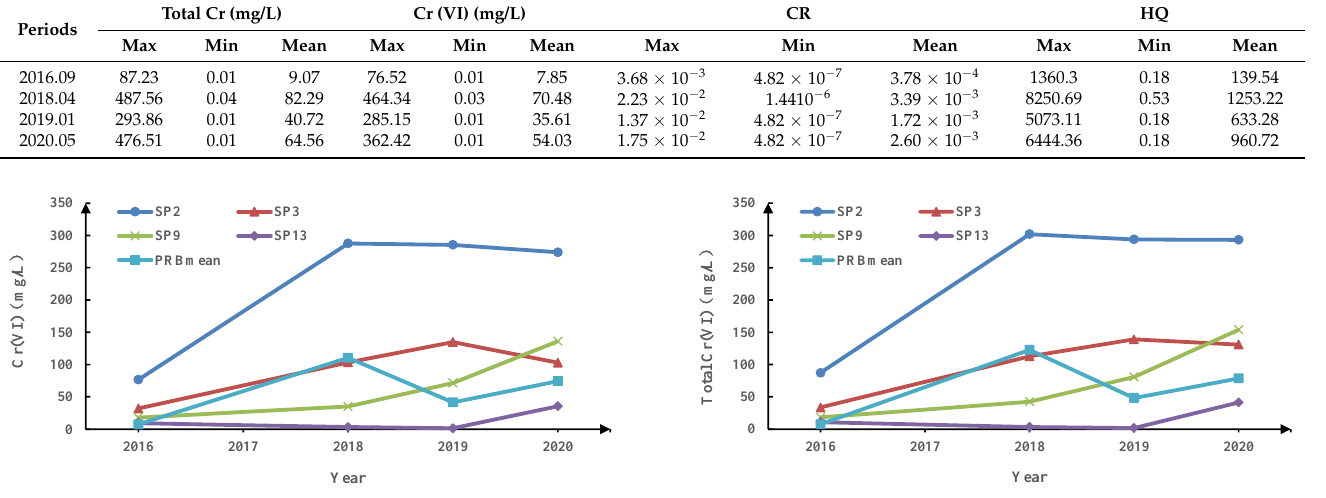
Table 2. Total Cr and Cr(VI) concentrations, carcinogenic and non-carcinogenic risks in groundwater samples from the study area at different periods.